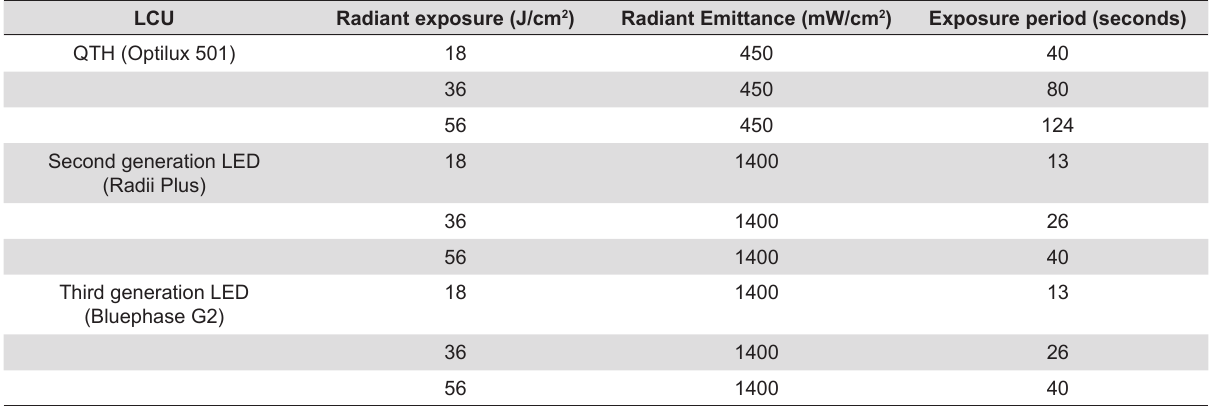
Table 2- LCUs, radiant exposure values, radiant emittance, and exposure period evaluated in the study